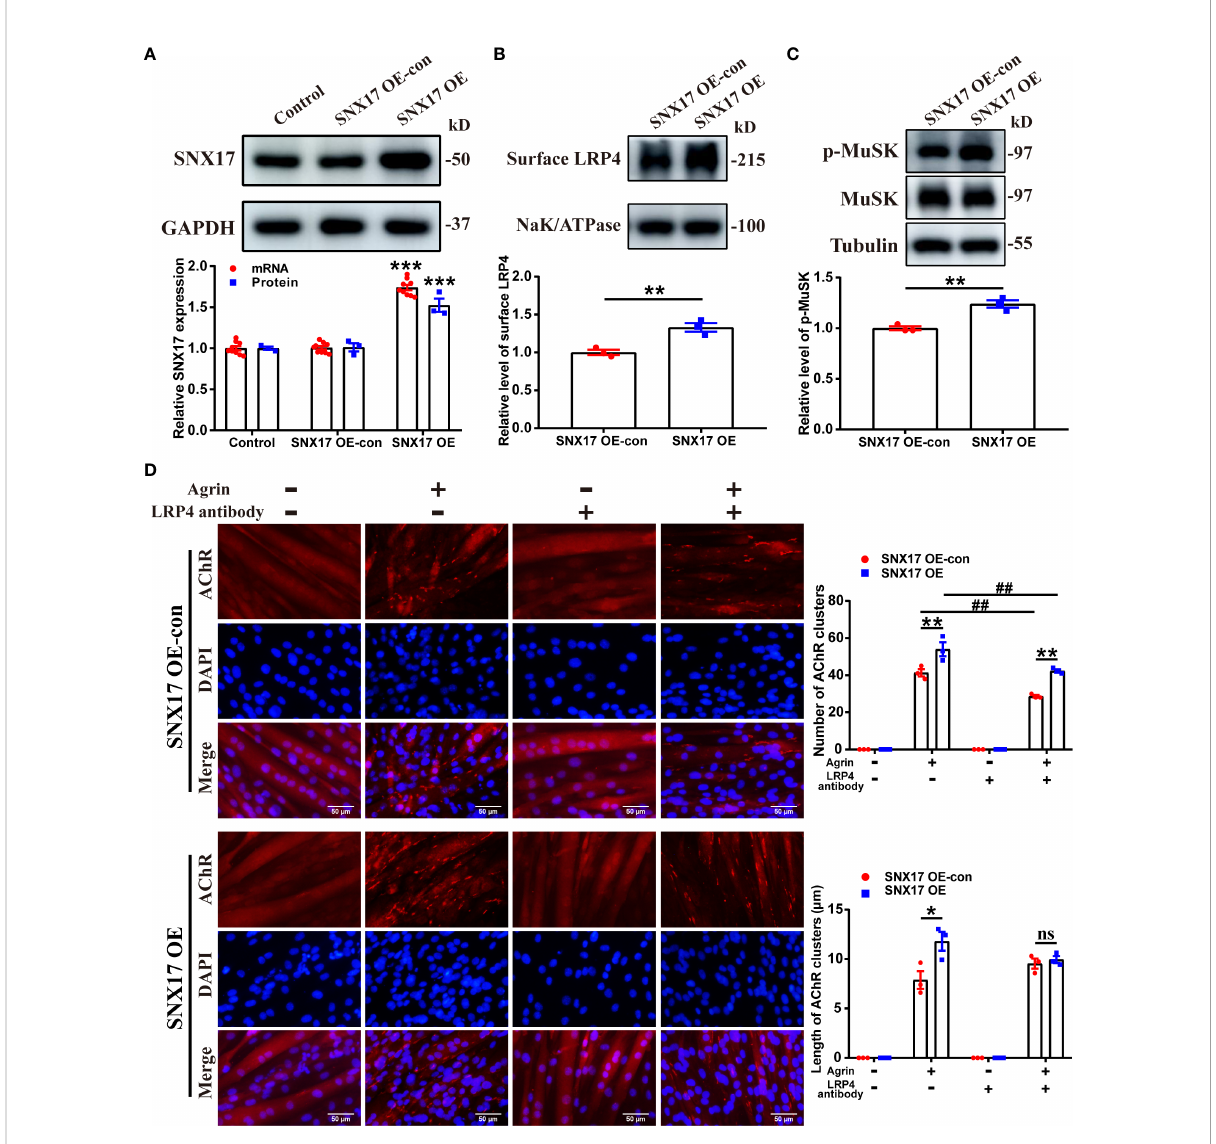
FIGURE 3 SNX17 overexpression increased cell surface LRP4 expression, MuSK phosphorylation, and AChR aggregation. (A) Western blotting and qPCR detection of SNX17 protein (n = 3/group) and mRNA (n = 9/group) expression, respectively, in lentivirus-infected cells. (B) Myotube cells were treated with 10 m g/mL anti-LRP4 antibody for 30 min to induce internalization of LRP4 protein on the membrane, following which the anti- LRP4 antibody was removed and the cells were cultured for 30 min, and then the content of LRP4 protein in the membrane protein was analyzed by Western Blotting. n = 3/group. (C) Myotube cells were treated with 10 m g/mL anti-LRP4 antibody for 30 min, after which the anti- LRP4 antibody was removed, the cells were incubated with 10 ng/mL Agrin for 16 h, and the expression of MuSK and p-MuSK in total protein was analyzed by Western Blotting. n = 3/group. (D) AChR clusters (red) on lentivirus-infected C2C12 myotubes were labeled with R-BTX after application of separate or mixed Agrin and anti-LRP4 antibody, the nuclei were stained with DAPI (blue), and the number of AChR clusters on myotubes was counted and the length of AChR clusters was analyzed by ImageJ software. n = 3/group; Scale bar = 50 m m. * represents SNX17 OE-con vs. SNX17 OE. All data are presented as mean ± SEM. * P <0.05, ** P <0.01, *** P <0.001, ## P <0.01. AChR, acetylcholine receptor; EAMG, experimental autoimmune myasthenia gravis; LRP4, low-density lipoprotein receptor-related protein 4; MuSK, muscle-speci fi c receptor tyrosine kinase; R-BTX, rhodamine-labeled bungarotoxin; SEM, Standard Error of Mean; SNX17, sorting nexin 17. ns, no signi fi